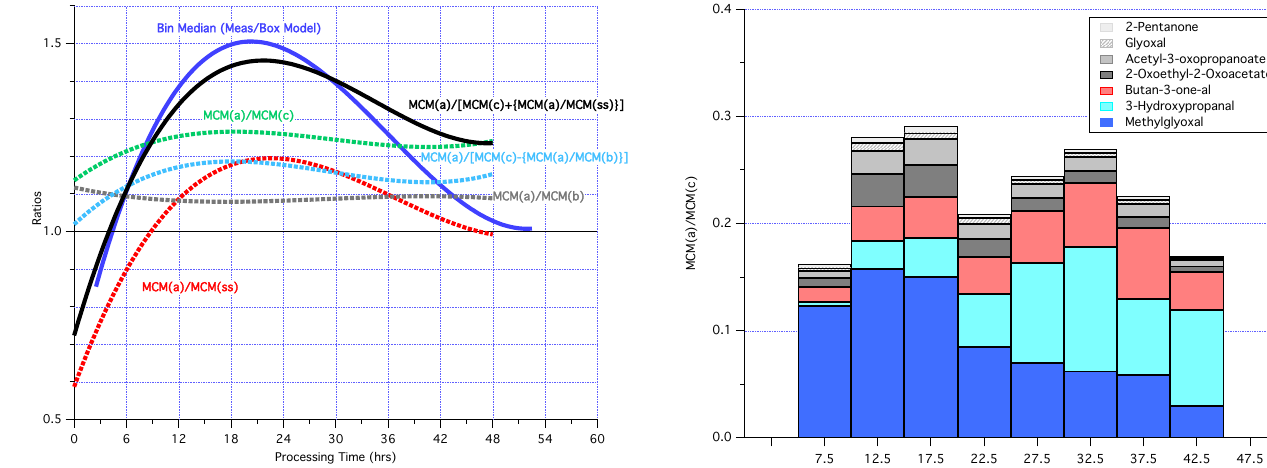
Fig. 16. The 7 major species responsible for producing the CH 2 O that is not accounted for when constraining species #2 & #3 in Table A3 to 0 throughout the model run (green profile of Fig. 15). These species are multiply-substituted second-and higher- generational products of species for which the MCM was initial-